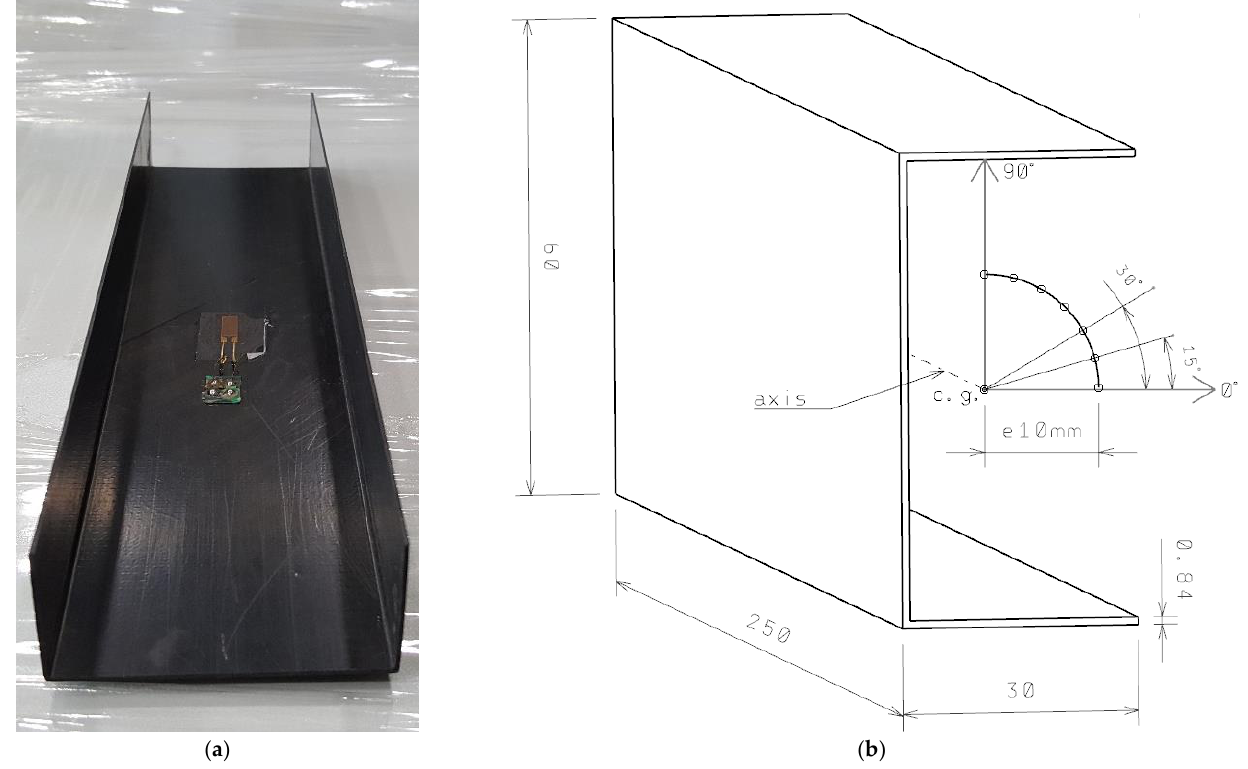
Figure 1. Channel column: ( a ) actual specimen, ( b ) geometrical model of a column under eccentric compression.